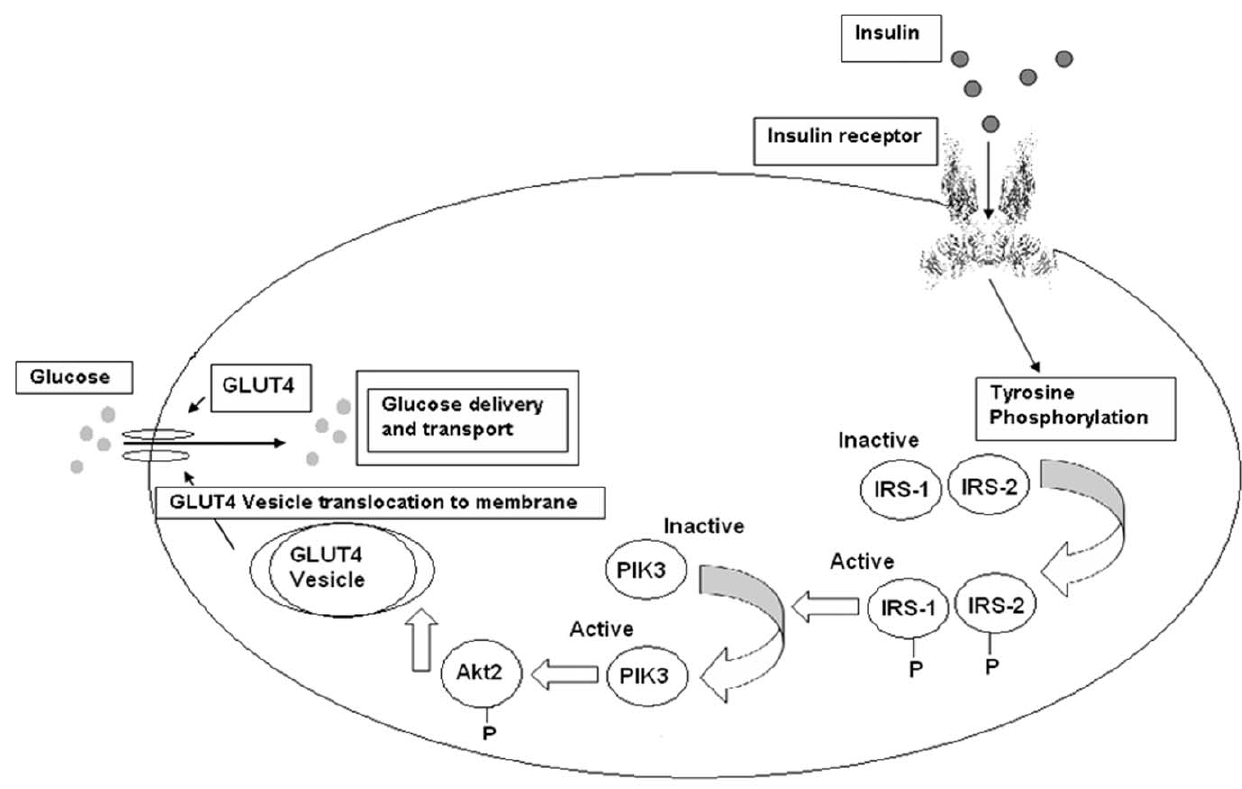
Figure 1. Insulin signal transduction pathway. The damage of insulin signal transduction causes insulin resistance, which is one of the main causes for type 2 diabetes.